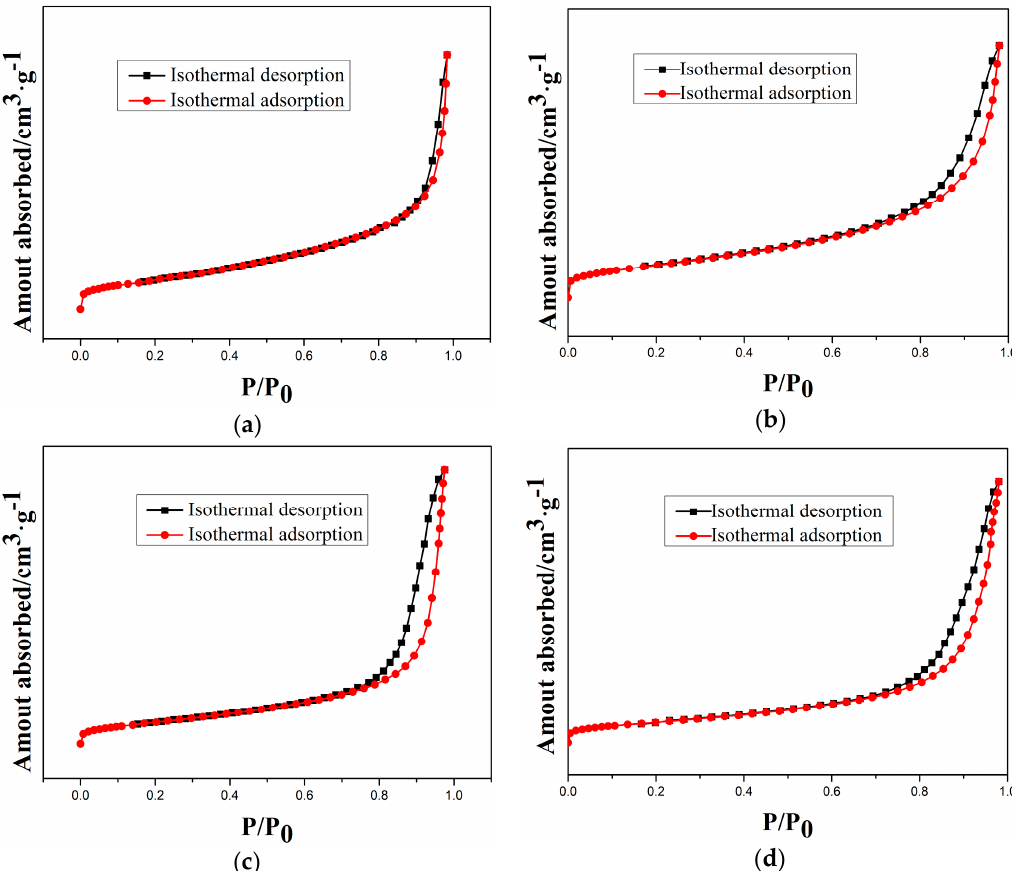
Figure 9. N 2 isothermal absorption and desorption curves of samples at different etching times: ( a ) 10 min; ( b ) 20 min; ( c ) 30 min; and ( d ) 40 min.